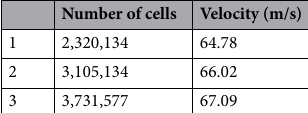
Table 2. Grid independence study.